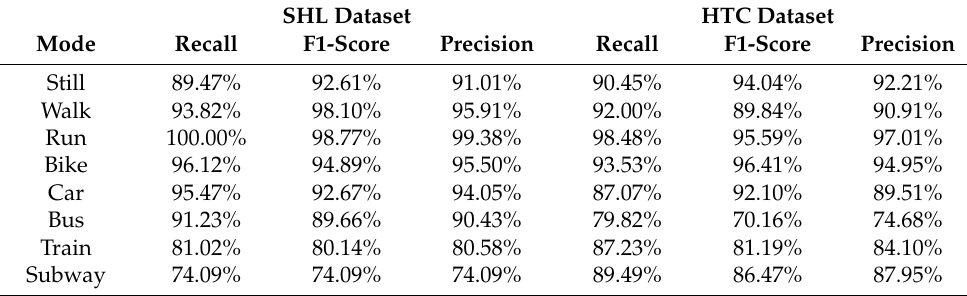
Table 6. Experimental results of the TCMH model.